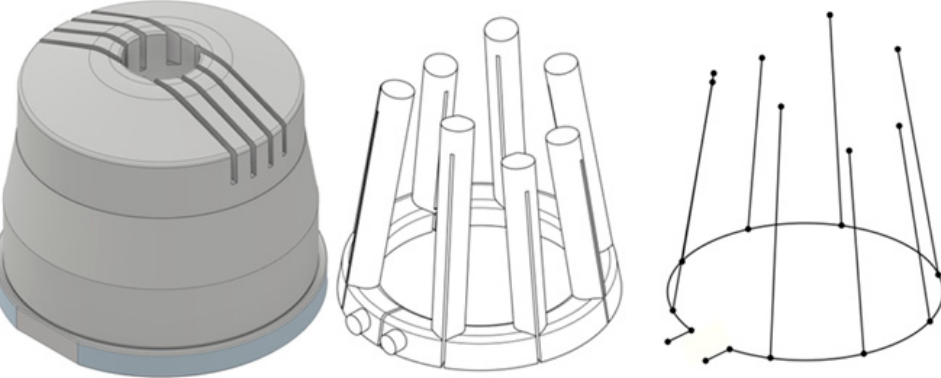
Figure 7. CAD model of the mold core ( left ), initial cooling system ( middle ), channel axes ( right ).